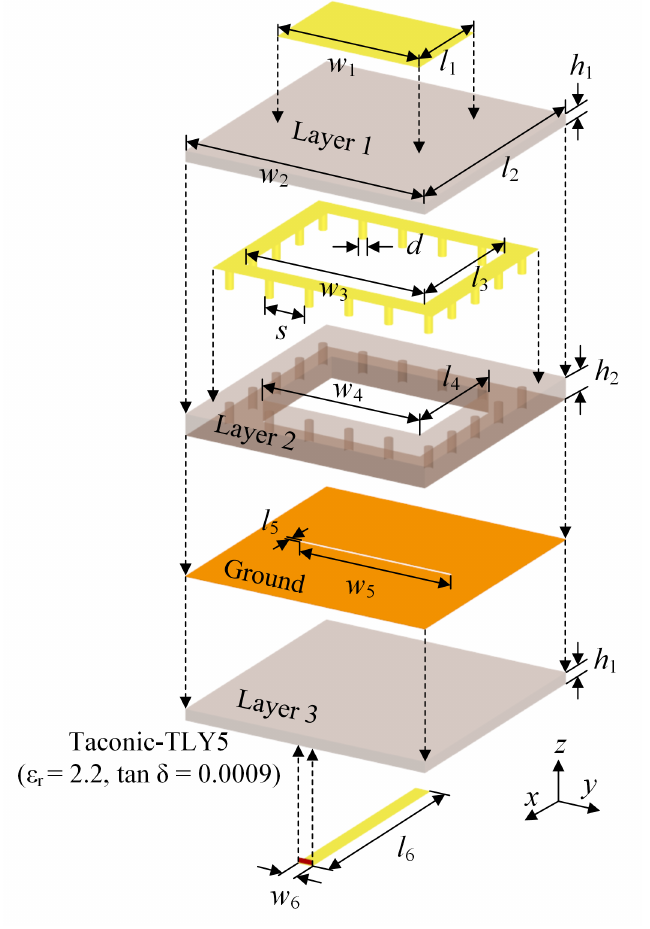
Figure 1. Geometry of the proposed